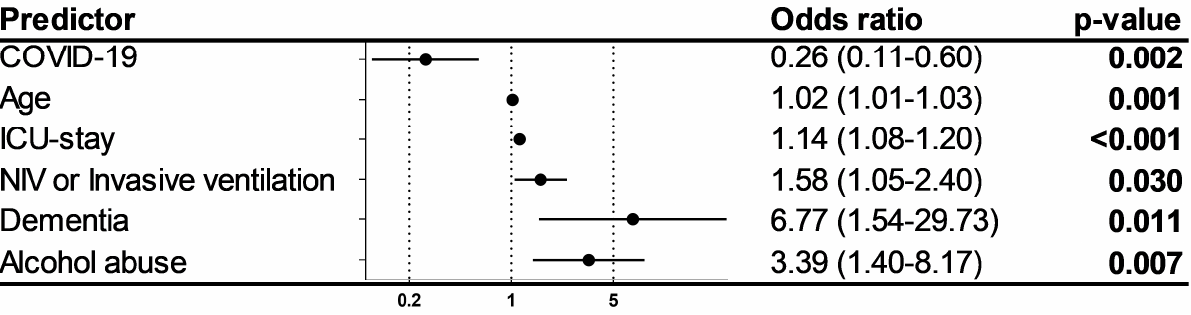
Figure 4. Predictors of delirium. Figure shows multivariable logistic regression analysis with odds ratio (95% confidence interval) of different predictors for delirium diagnosed by Nudesc. Odds ratios >1 mark positive predictors, odds ratio <1 negative predictors . Figure 3. Fraction of delirium positive patients in different subgroups. Graph shows the fraction of